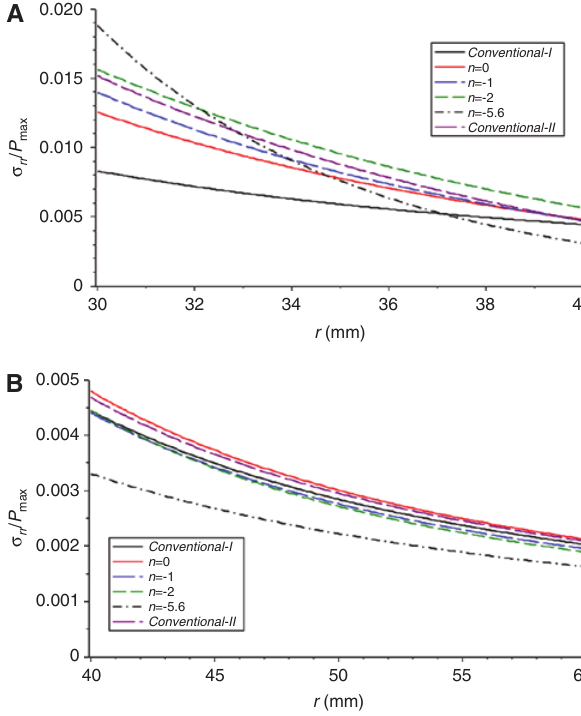
Figure 11: Non-dimensional radial stress of described models at θ = 0: (A) in inter-layer and (B) in surrounding plate near field.